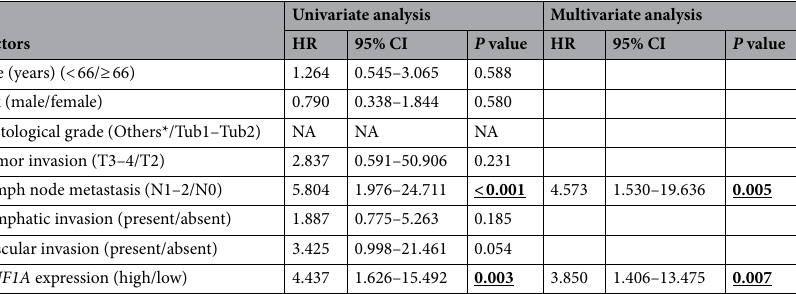
Table 3. Univariate and multivariate analyses of overall survival based on HNF1A expression and clinicopathological variables. *Others: poorly differentiated, mucinous adenocarcinoma, or squamous cell carcinoma. The significance for the boldunderline indicate independent risk from multivariate analysis.